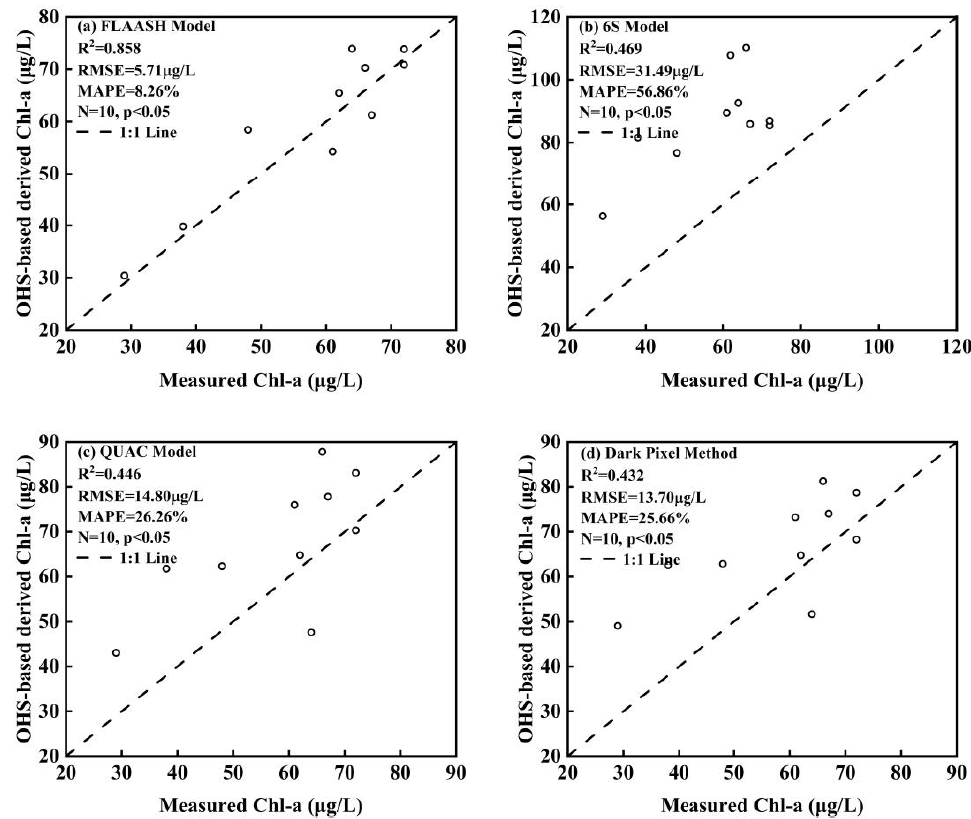
Figure 4. Comparison of OHS-derived and measured Chl-a for OHS imagery. ( a – d ) respectively represent the validation of Chl-a concentration inversion results after using different atmospheric correction algorithms such as the FLAASH model, 6S model, QUAC model, and dark pixel method.